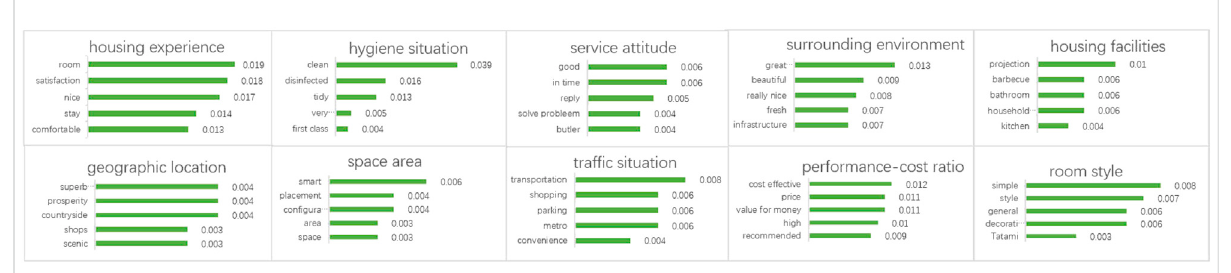
FIGURE 3 Results of the LDA